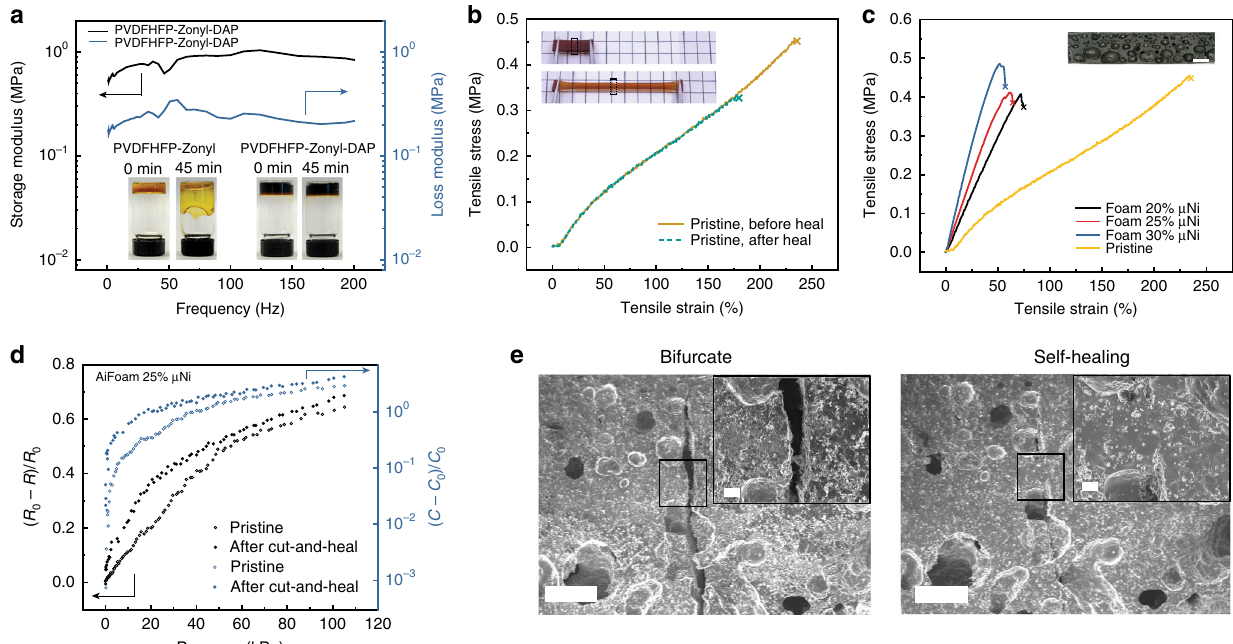
Fig. 3 Characterization of a low-modulus, elastic, and self-healing foam material. a DMA result of the base polymer showing its viscoelasticity. PVDF- HFP-Zonyl represents the uncrosslinked material and PVDF-HFP-Zonyl-DAP represents the cross-linked material. Left insets (PVDF-HFP-Zonyl, 0 and 45 min) show the fl owability of the material before crosslink. Right insets (PVDF-HFP-Zonyl-DAP, 0 and 45 min) show the solid-state material after crosslink. b Typical stress – strain curves of original and healed base elastomer material. The sample is bifurcated and then self-healed at 70 °C for 4 days. Top inset shows the self-healed sample at the original state. Bottom inset shows the self-healed sample being stretched. The dotted black boxes show the bifurcated and heal region on the sample. c Stress – strain curves of base elastomer and foam materials with different volume fractional μ Ni loadings. Inset: An optical image of the foam structure. Scale bar: 1 mm. d Graph shows the self-healing of piezoresistive and piezocapacitive behaviors of AiFoam (with 25 vol% μ Ni). R 0 and C 0 represent the initial resistance and capacitance of the sensor, whereas R and C represent the resistance and capacitance of the sensor during the pressure test. The data were simultaneously collected. e Cross-sectional SEM images reveal the self-healing performance of foam material; left bifurcated; right self-healed at 70 °C for 4 days. Insets: The zoom-in SEM images of the black boxes. Scale bar: 50 μ